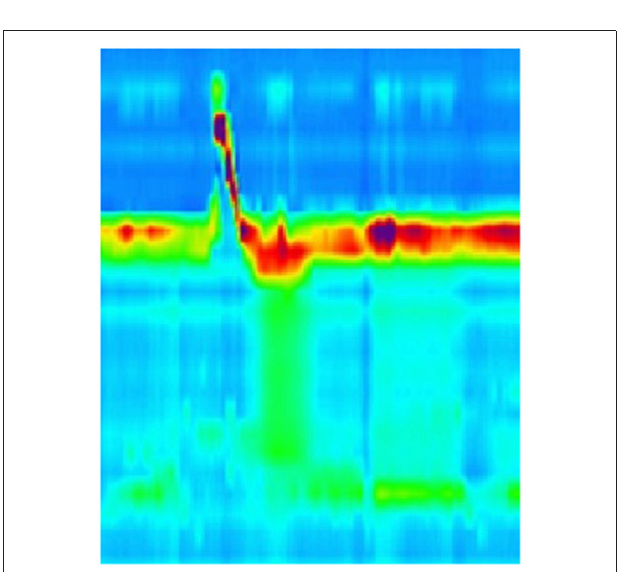
FIGURE 5 | High resolution manometry in eosinophilic esophagitis showing pan-esophageal pressurization with wet swallow in a